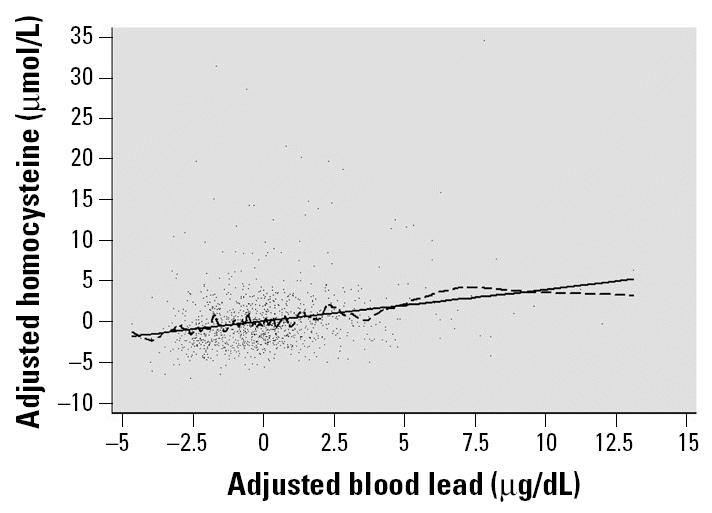
Smoothed plot of residuals of blood lead and homocysteine levels, controlling for covariates. Values were adjusted for age, sex, race/ethnicity, BMI, educational level, and tobacco and alcohol use. The three data points with blood lead concentrations > 15 μg/dL have been excluded from the plot (but not from the regression model) so that the portion of the plot with the most data could be more clearly visualized. The solid line is predicted linear fit, and the dashed line is from a locally weighted smoothing fit (lowess bandwidth, 0.05) (Cleveland 1979).